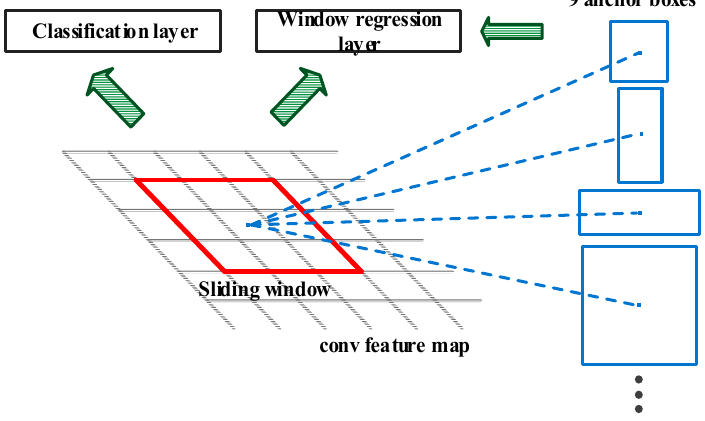
Figure 6. Process of generate candidate object area structure using RPN.